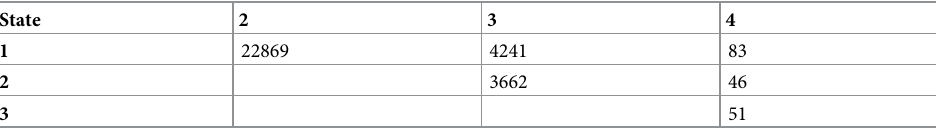
Table 3. Numbers of conflicts between each pair of states for a =